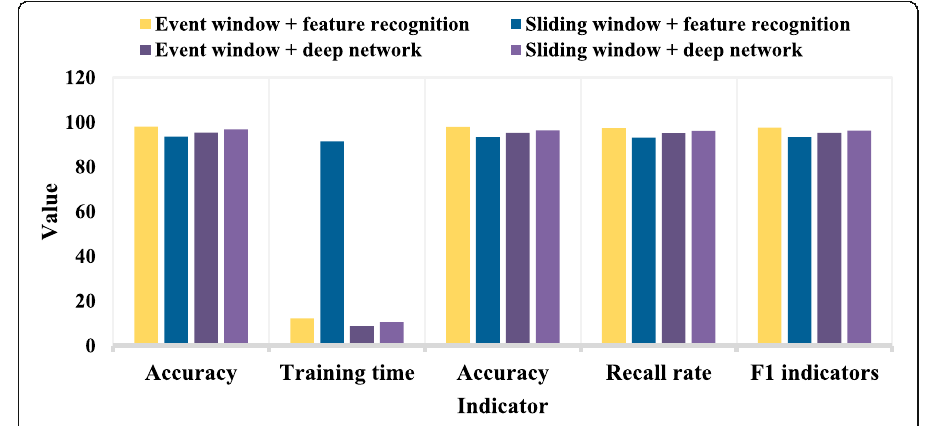
Fig. 8 Performance indicators for motion recognition